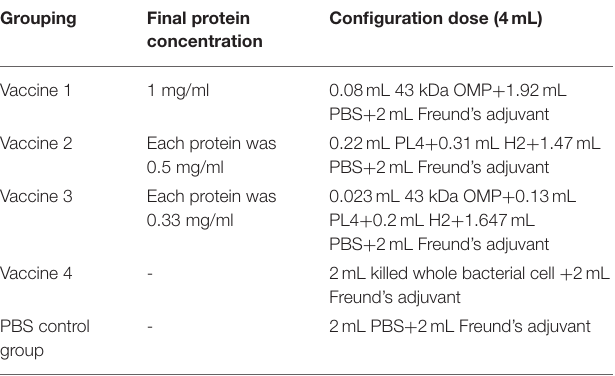
TABLE 1 | The proportion of each component vaccine. Grouping